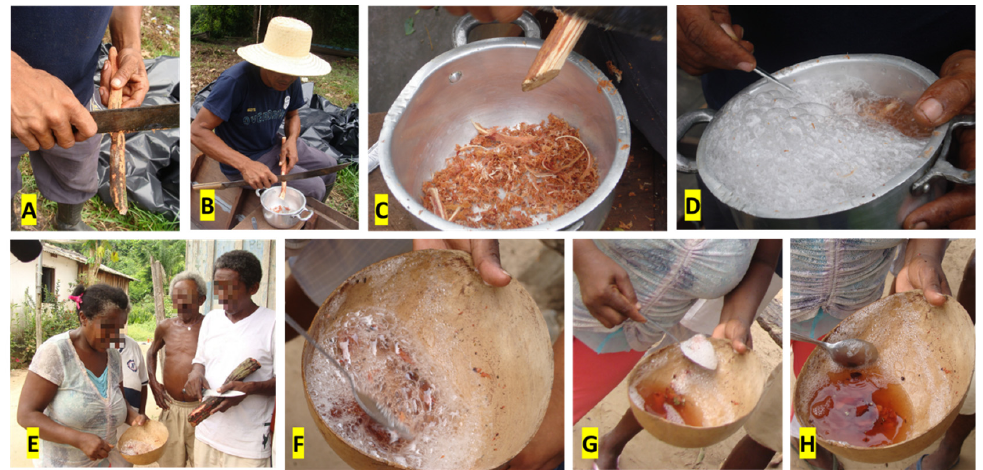
Figure 2. Preparation of the “saracura-mirá” drink. ( A ) Cleaning a piece of vine; ( B , C ) the bark is scraped into a bowl; ( D – F ) it is vigorously beaten with water, until abundant foam is formed; ( G ) the foam is removed and discarded. This process is repeated seven times; ( H ) the drink is ready after about 10 min of preparation.